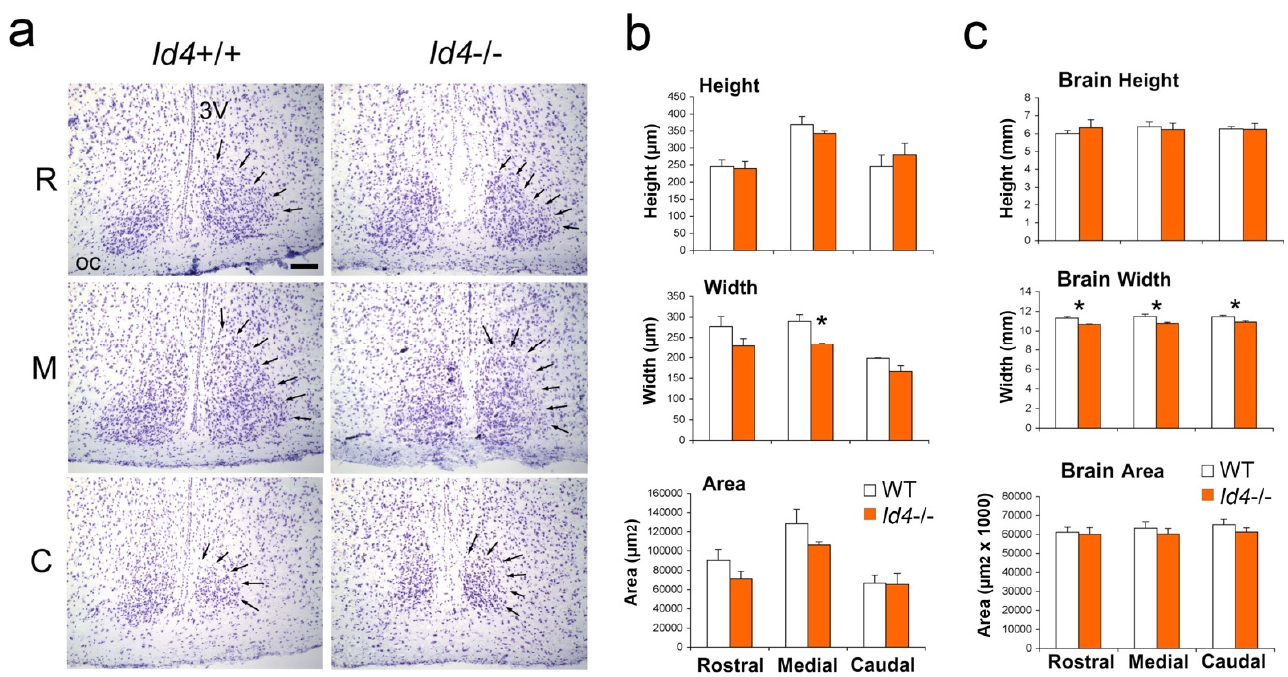
Figure 5. Histological analysis of suprachiasmatic nucleus (SCN) and whole brain shows anatomical differences between Id4 − / − and wild ‐ type mice. ( a ) Cresyl violet ‐ stained coronal sections through rostral (R), medial (M), and caudal (C) aspects of Id4 +/+ and Id4 − / − SCN. Arrows indicate perimeter of the SCN. OC, optic chiasm; 3V, third ventricle. Scale bar = 100 μ m. ( b , c ) Analysis of height, width, and area of rostral, medial, and causal aspects of SCN and whole forebrain, respectively. Brain assessed in coronal aspect. Values shown in the histogram are group means ± SEM for wild ‐ type (WT) (white) and Id4 − / − (orange) mice (wild type, n = 4; Id4 − / − , n = 4). Significant differences were detected in width of SCN and forebrain between genotypes (* p < 0.05).